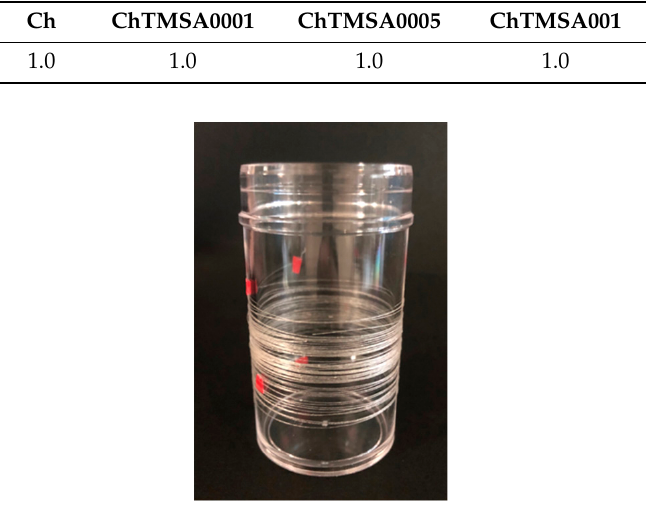
Figure 3. Photograph of the chitosan − TMSA microfiber (ChTMSA001).